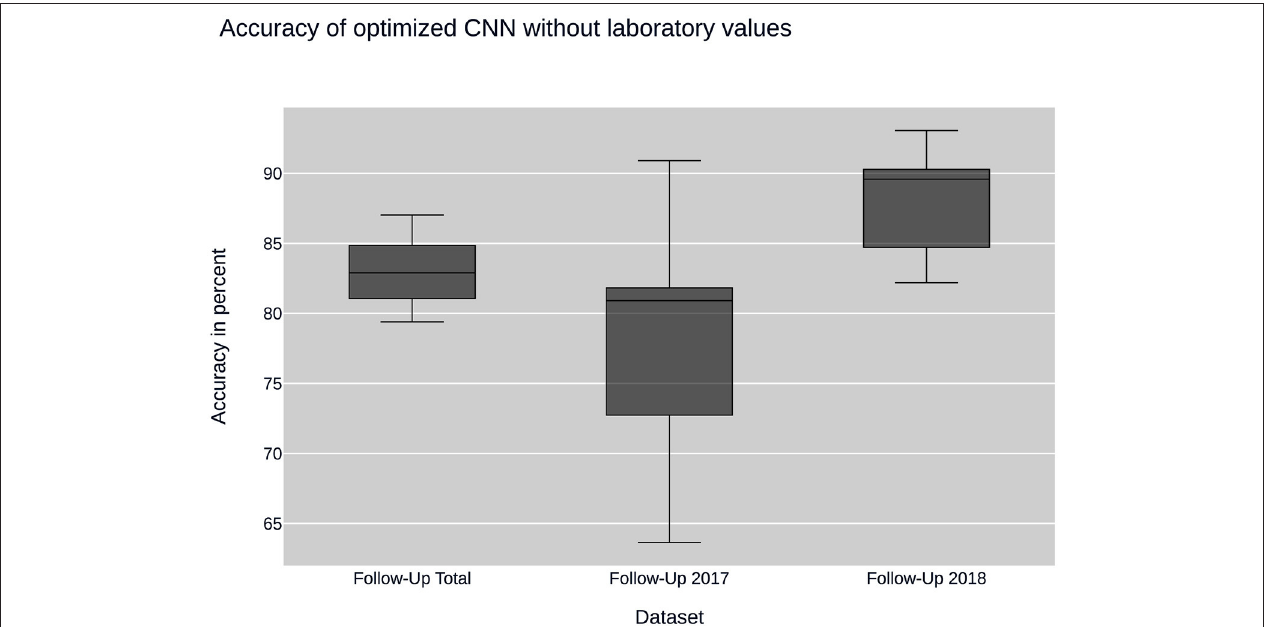
FIGURE 3 | CNN performance without laboratory values: plots the performance of the convolutional neural network (CNN) when using sub datasets selected by time of input. None of the datasets contain laboratory values.